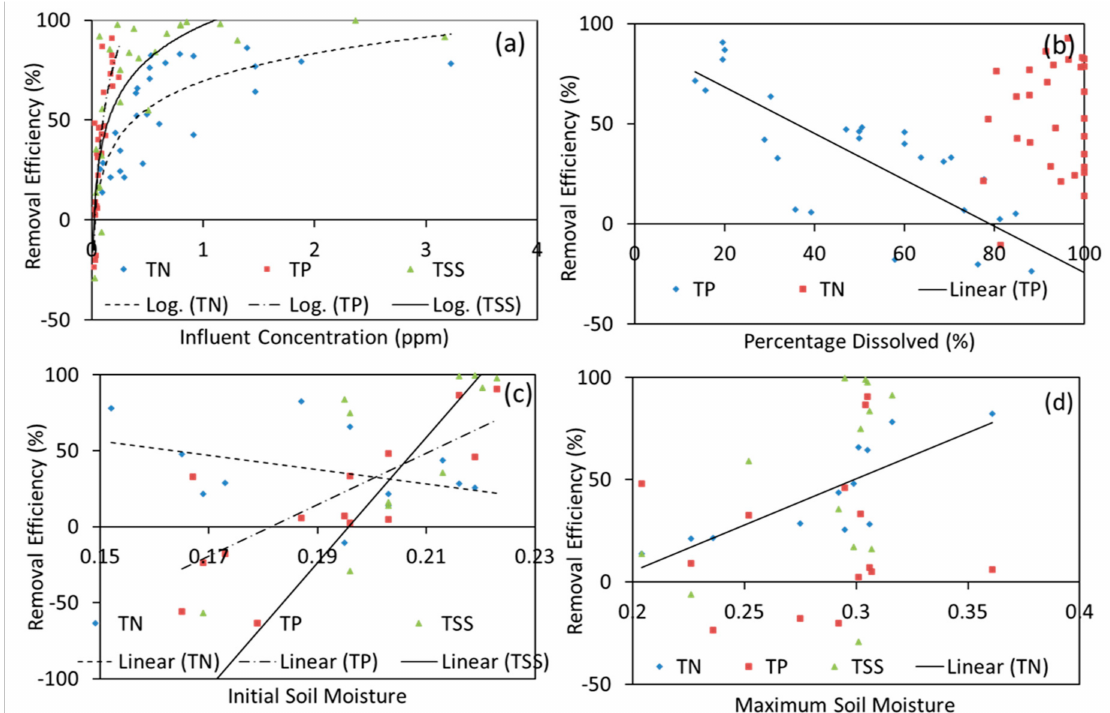
Figure 9. Environmental factors that affect the performance of MBT: ( a ) influent of pollutant, ( b ) % of dissolved pollutant, ( c ) initial soil moisture, and ( d ) maximum soil